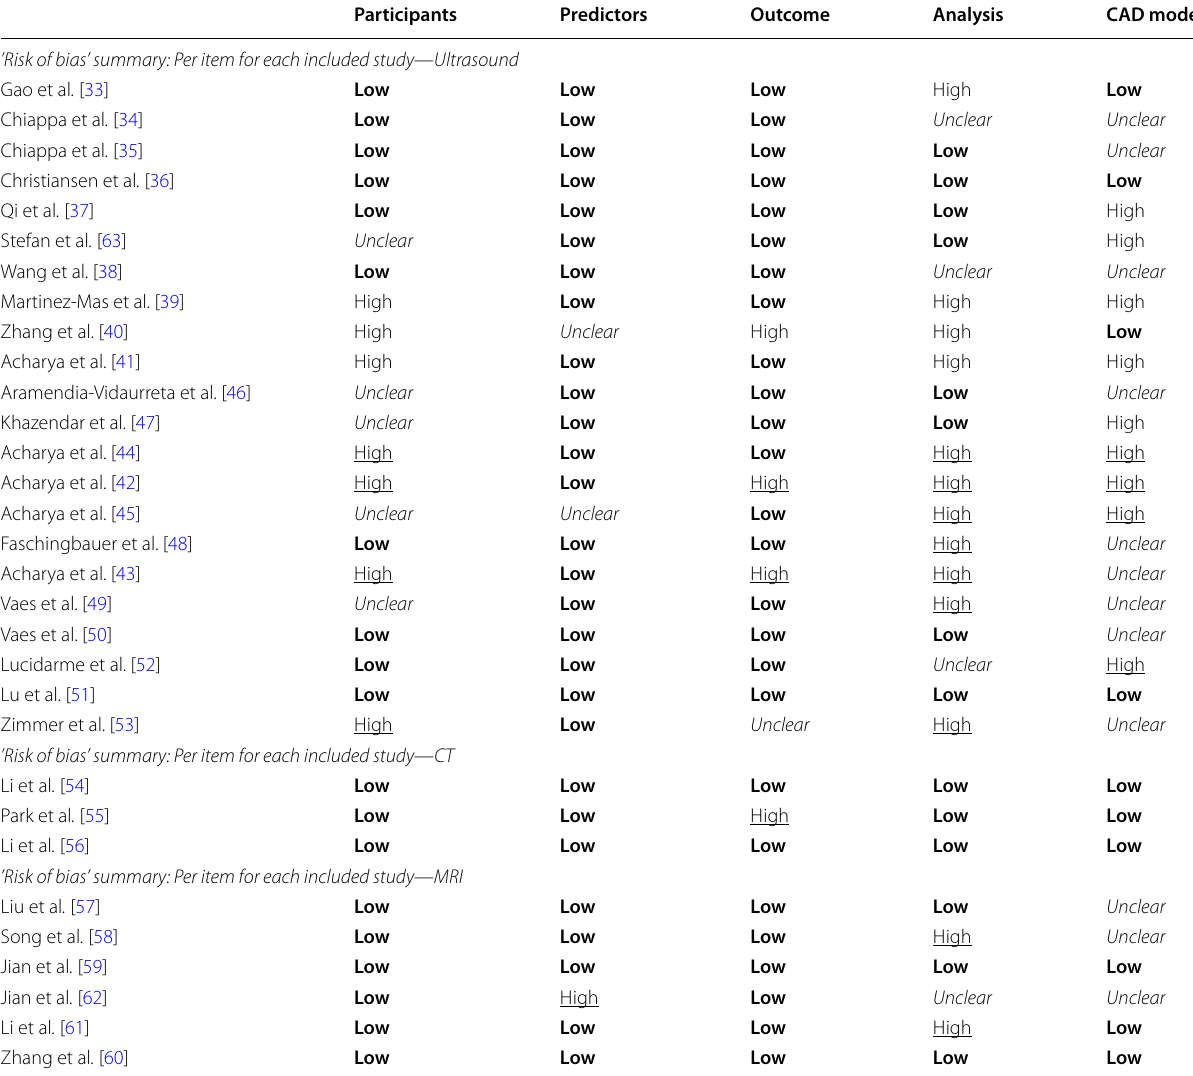
Table 2 ’Risk of bias’ summary: review authors’ judgements about each risk of bias item for each included